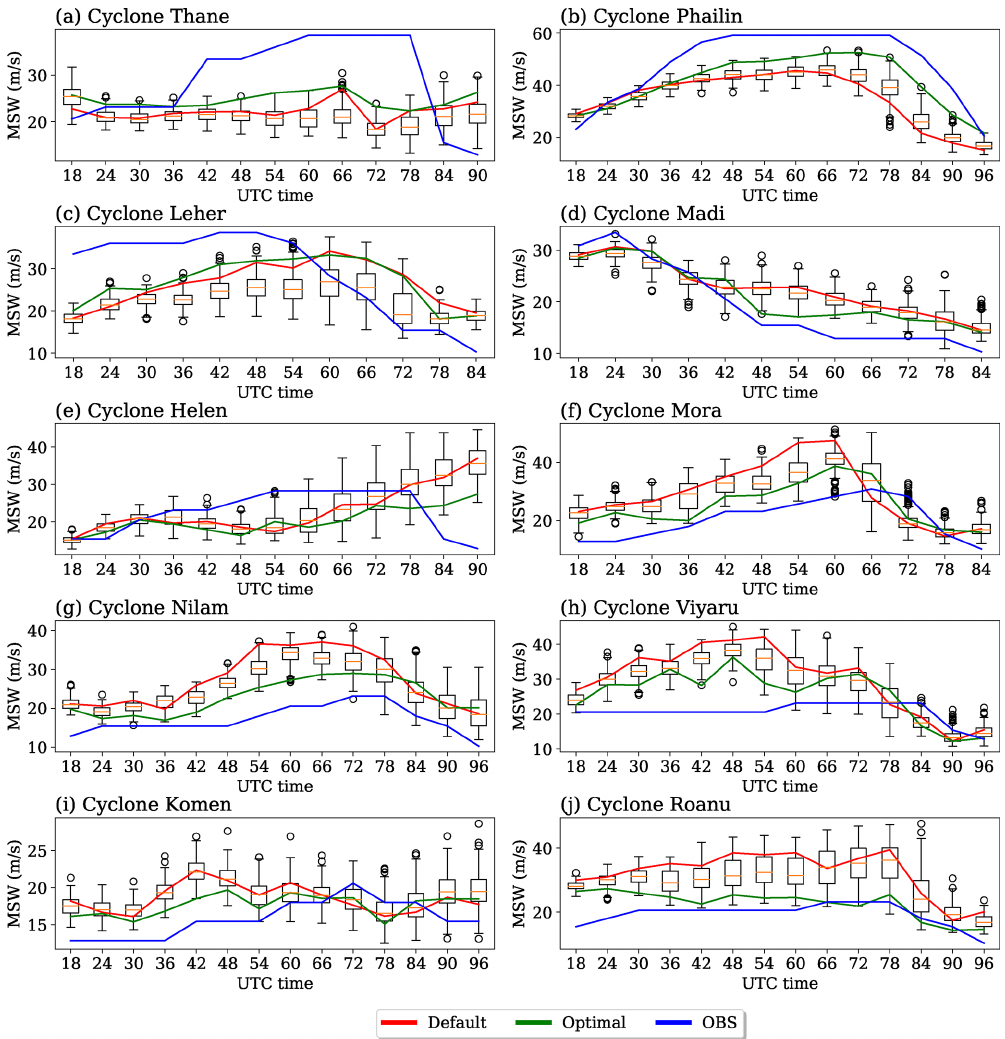
Figure 18. Comparisons of 3.5d maximum sustained wind speed (MSW) of all cyclone simulations using the WRF model with the default and the optimal parameters. The boxplots of individual cyclones are obtained from the 250 simulations used for the MARS and Sobol’ analysis. The green line shows the simulation with default parameters, the blue line shows the simulations with optimal parameters, and the red line shows the observed MSW. The data are collected at a 6h interval and are plotted